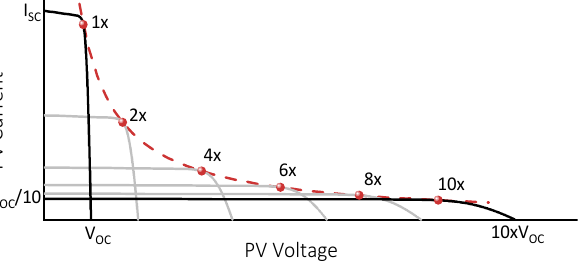
Figure 2. Modified I-V characteristic at the output of the voltage-multiplied PV module.